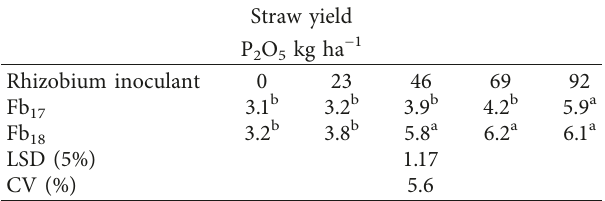
Table 15: Interaction effects of rhizobium inoculation and P fertilizer rate on straw